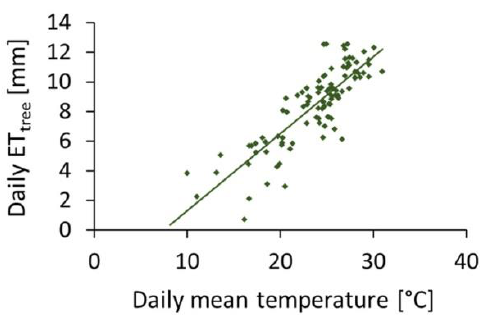
Figure 11. Daily mean air temperature versus tree water consumption (ET trees ) of a single row poplar tree wind break. For the formula of this trend line, see Equation (5).